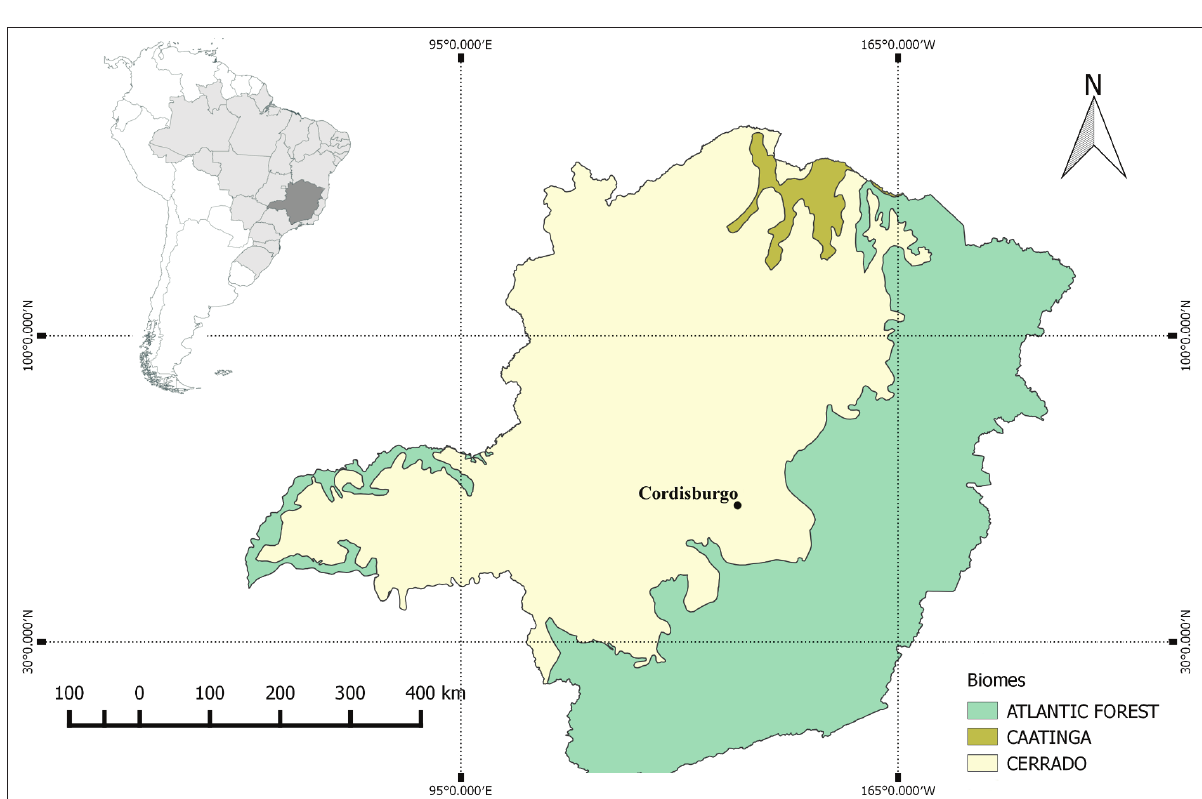
Figure 1. Map of Minas Gerais (Brazil), with the study location, municipality of Cordisburgo.